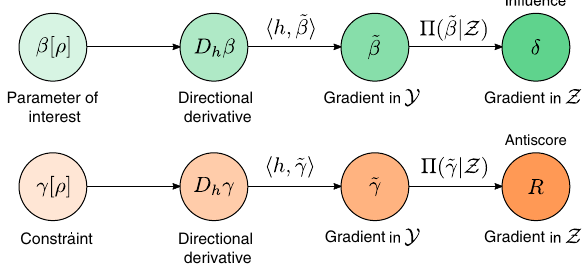
FIG. 2. Top (for Sec. III D): Steps to obtain an influence operator δ from the functional β ½ ρ (cid:2) via Eqs. (3.33), (3.34), and (3.36). Bottom (for Sec. VA): Steps to obtain the antiscore operators that span T ⊥ via Eqs. (5.2) and